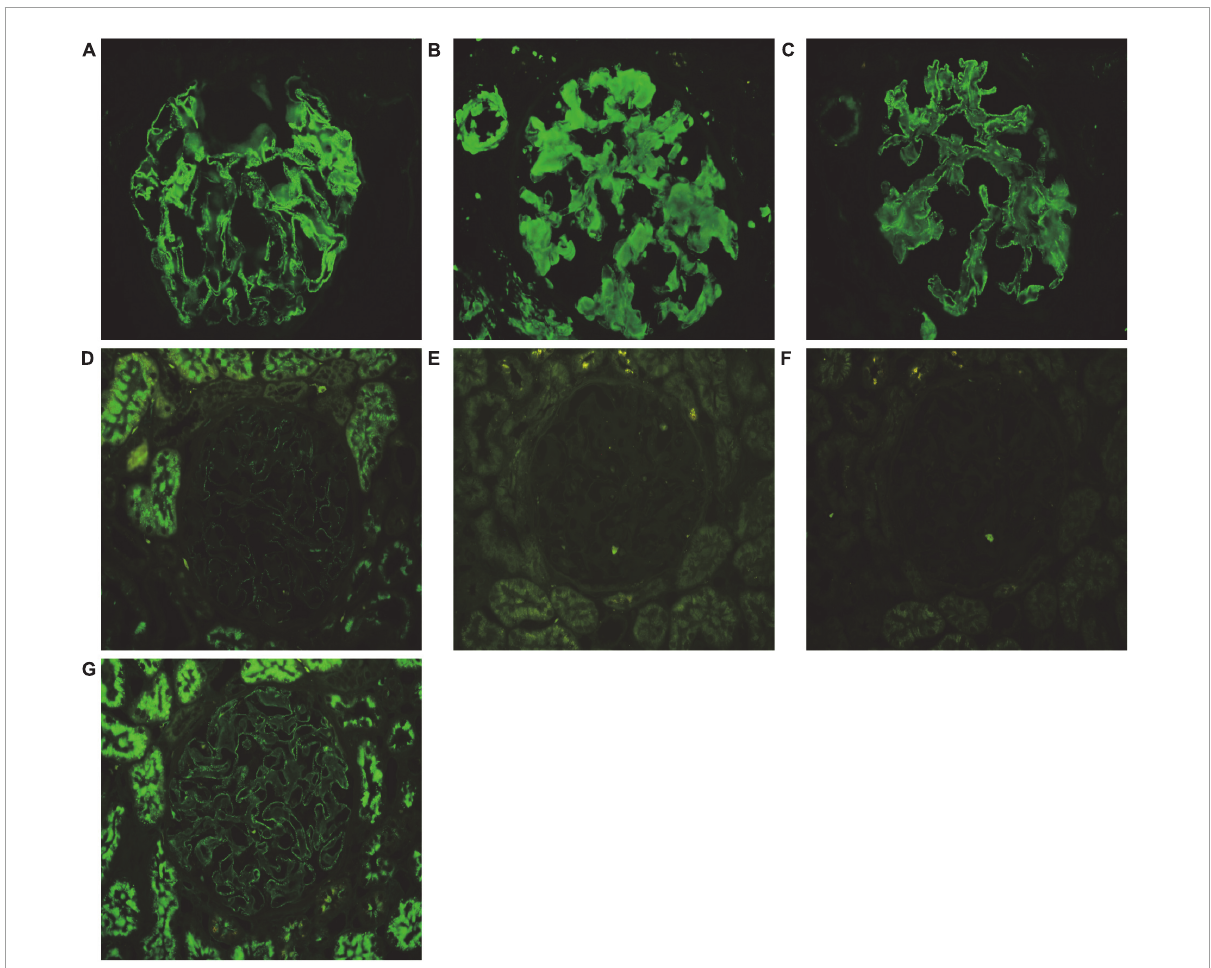
FIGURE2 Pathological features of immunofluorescence. (A) Granular deposition of IgG (+++) along the glomerular capillary walls (immunofluorescence, 400 × ). (B) Deposits of λ (++) along the arterioles, mesangial glomeruli, and capillary walls (immunofluorescence, 400 × ). (C) Deposits of κ (+) along the glomerular capillary walls (immunofluorescence, 400 × ). (D) Weak positive of IgG1 deposition in the glomerular basement membrane (immunofluorescence, 400 × ). (E) IgG2 was negative in the glomerular basement membrane (immunofluorescence, 400 × ). (F) IgG3 was negative in the glomerular basement membrane (immunofluorescence, 400 × ). (G) Positive of IgG4 deposition in the glomerular basement membrane (immunofluorescence, 400 × ). (A–C) Show the immunofluorescence of frozen section, and (D–G) show the immunofluorescence of paraffin